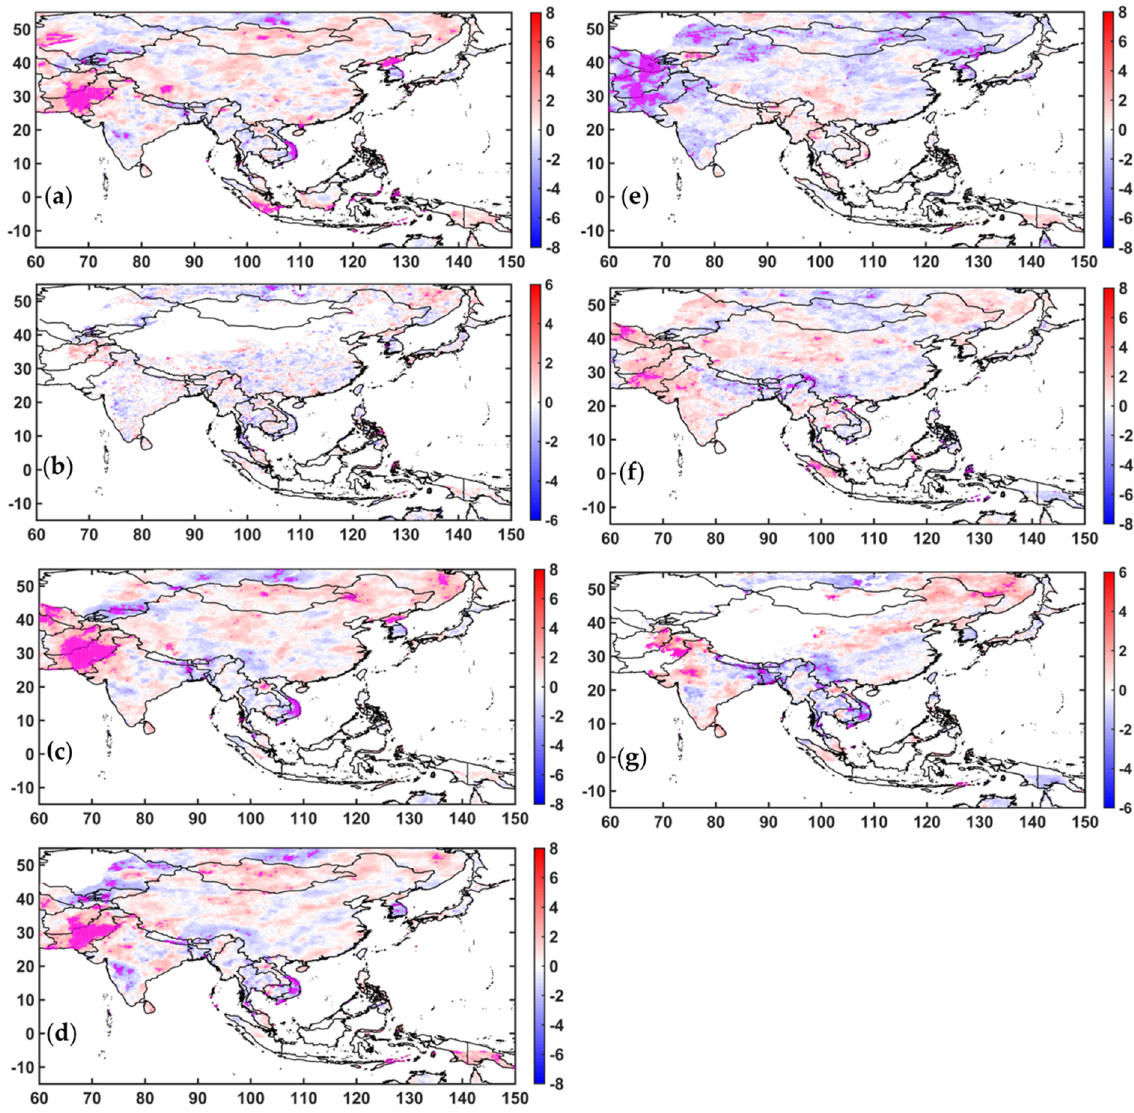
Figure 3. Spatial patterns of trends in extreme precipitation climate change indices over monsoon Asia during 1998–2015. Where ( a ) R × 1, ( b ) R × 5, ( c ) R95, ( d ) SDII ( e ) CDD, ( f ) CWD, and ( g ) R10. The significant trends are shown with magenta colored squares.